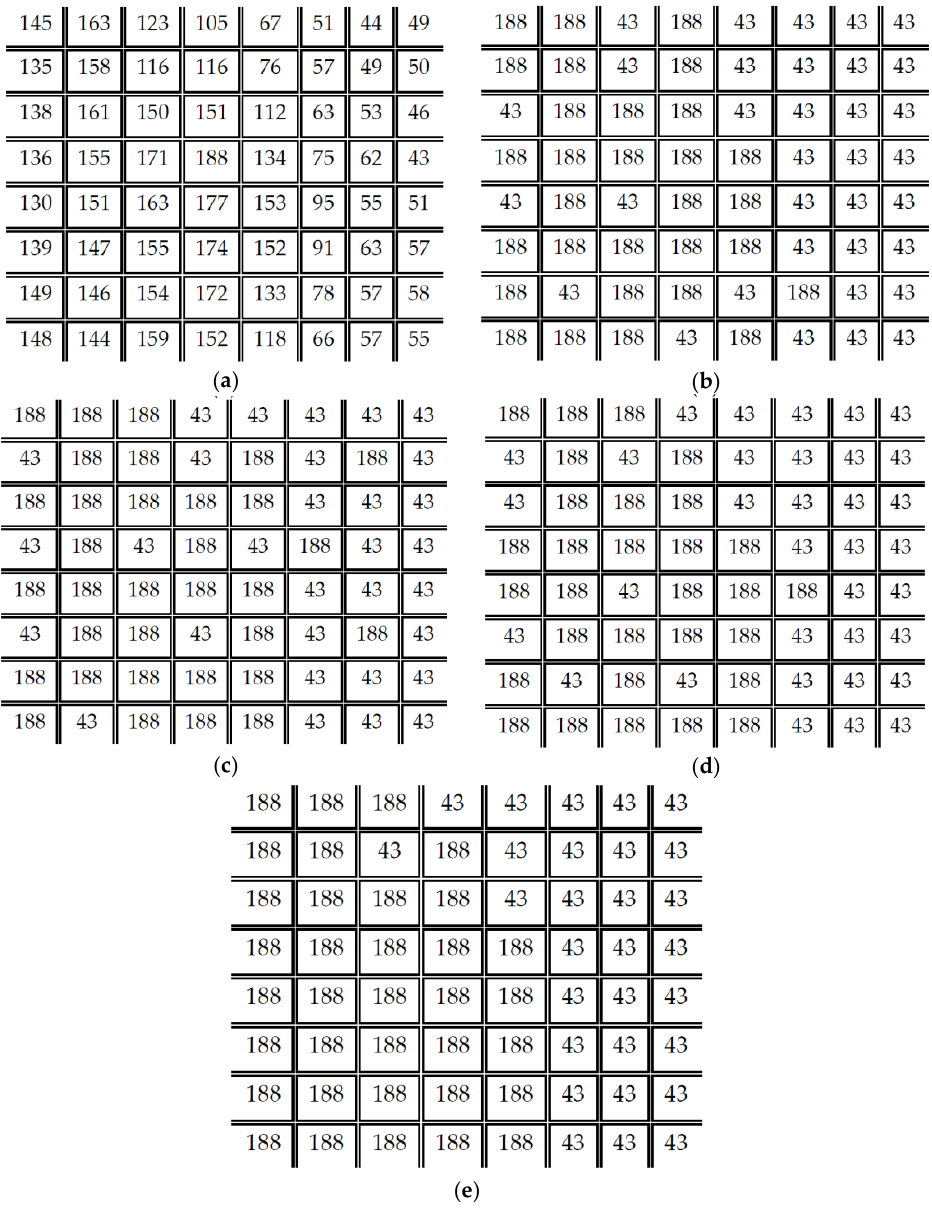
Figure 8. Numerical examples of HBTC process: ( a ) input image; ( b – e ) are 𝑔(𝑥,𝑦) using EDBTC, ODBTC, DDBTC and DDBTC Gaussian, respectively.